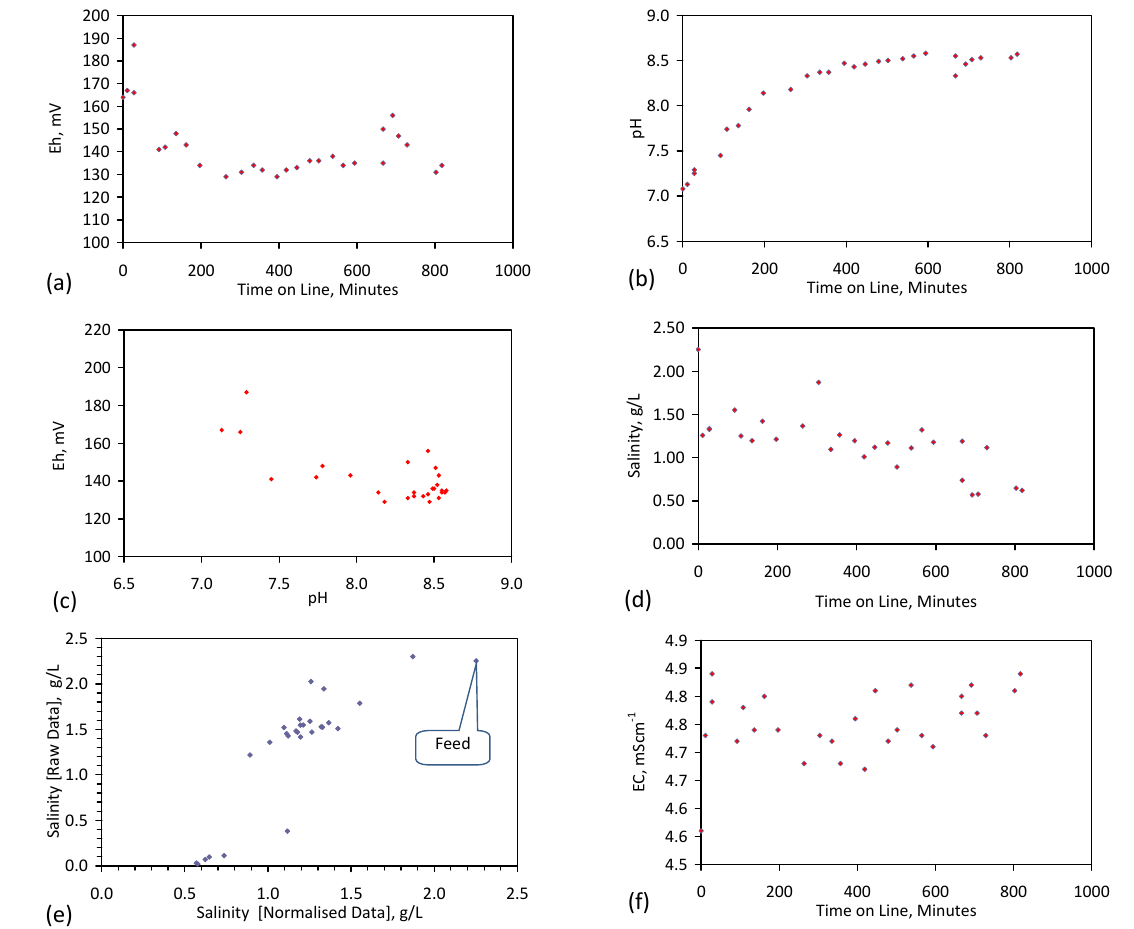
Figure C28. ZVM TPA example Trial E146. 8th Reuse; Operating Temperature: 15–21 °C; Oxidising Environment: Water volume in the reactor = 0.24 m 3 ; ZVM TPA from Trial E145 in a cartridge = 0.4 kg; Air flow = 120 L·h − 1 . ( a ) Eh vs. time; ( b ) pH vs. time; ( c ) pH vs. Eh; ( d ) Salinity vs. time; ( e ) Salinity calculated from normalised data vs. salinity calculated from raw data; ( f ) EC vs.